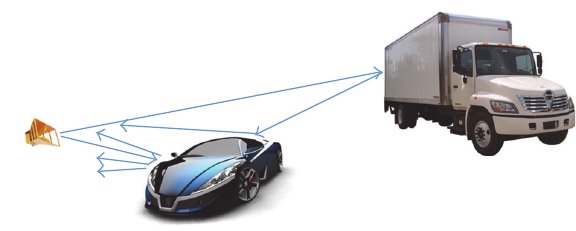
Figure 1: Multipath effects on a weak